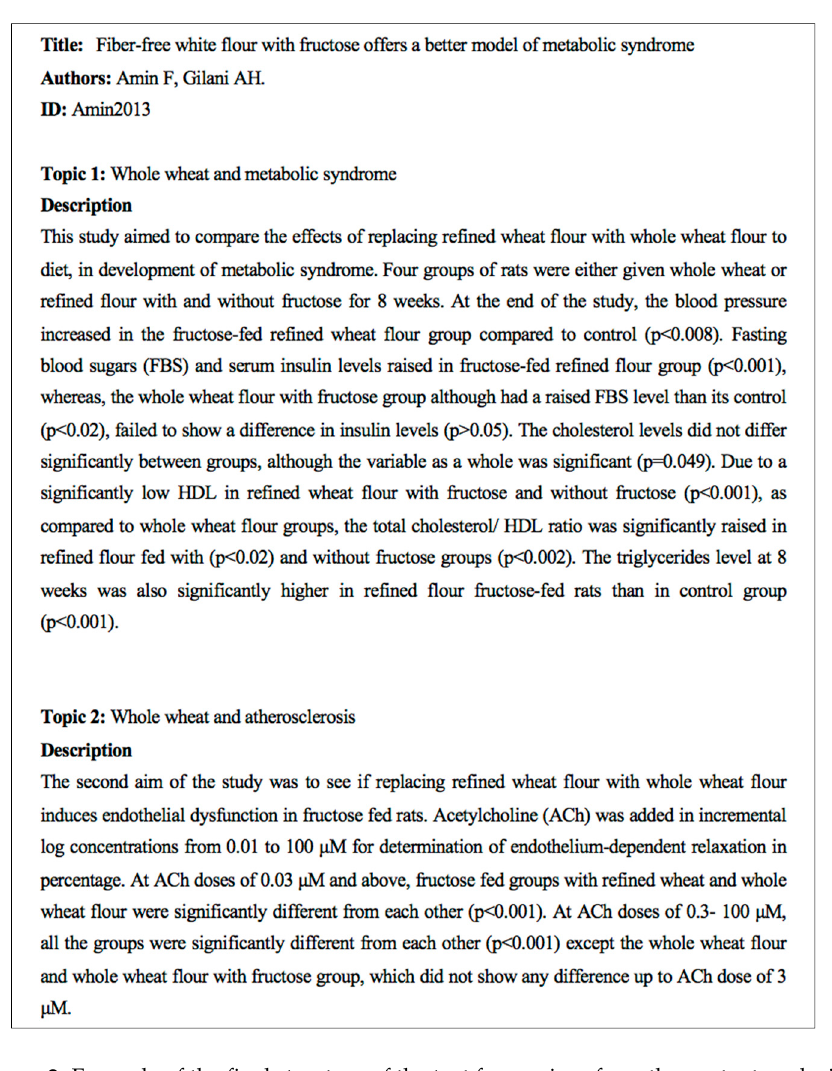
Figure 2. Example of the final structure of the text form arisen from the content analysis.